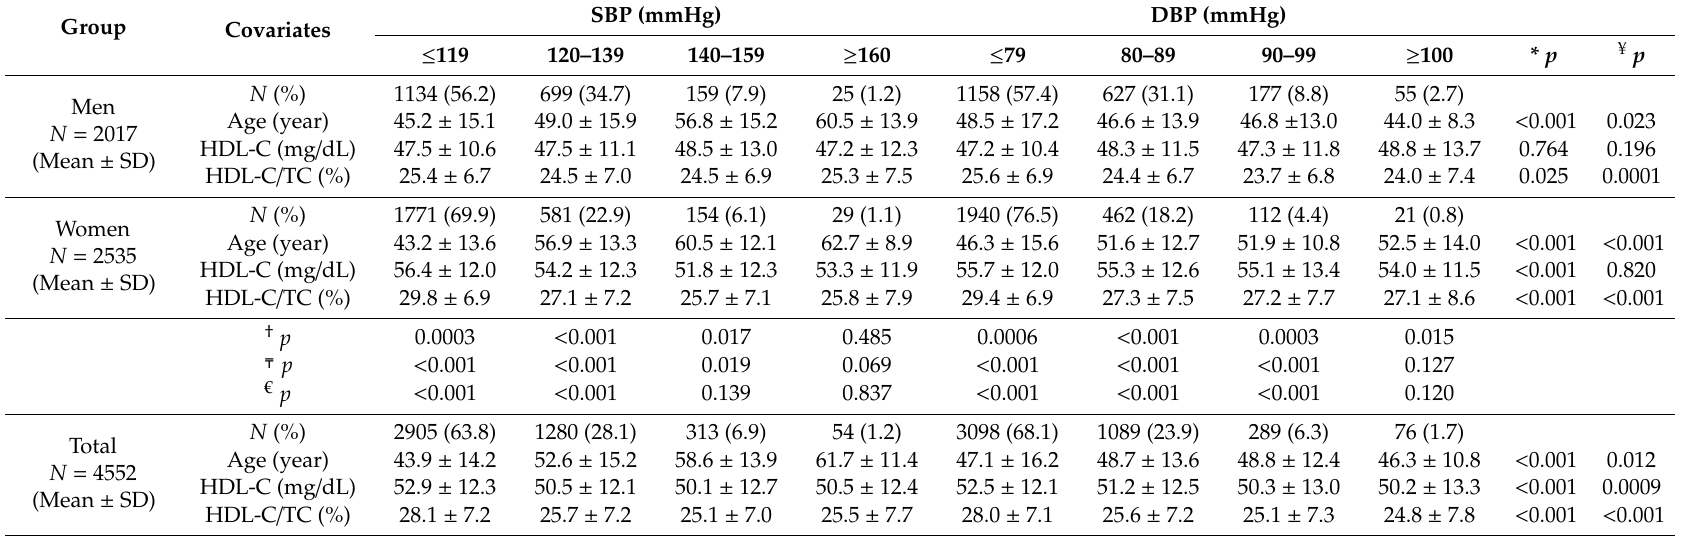
Table 2. Distribution of SBP, DBP, age and HDL-C in men and women from Korean national health and nutrition examination survey 2017.